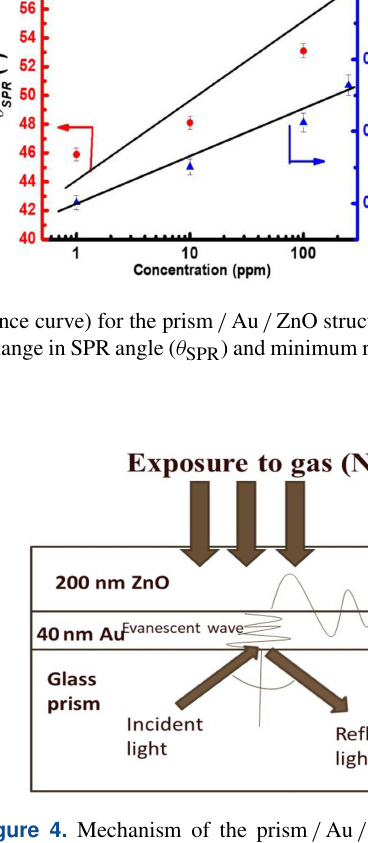
Figure 4. Mechanism of the prism / Au / ZnO system based on NO 2